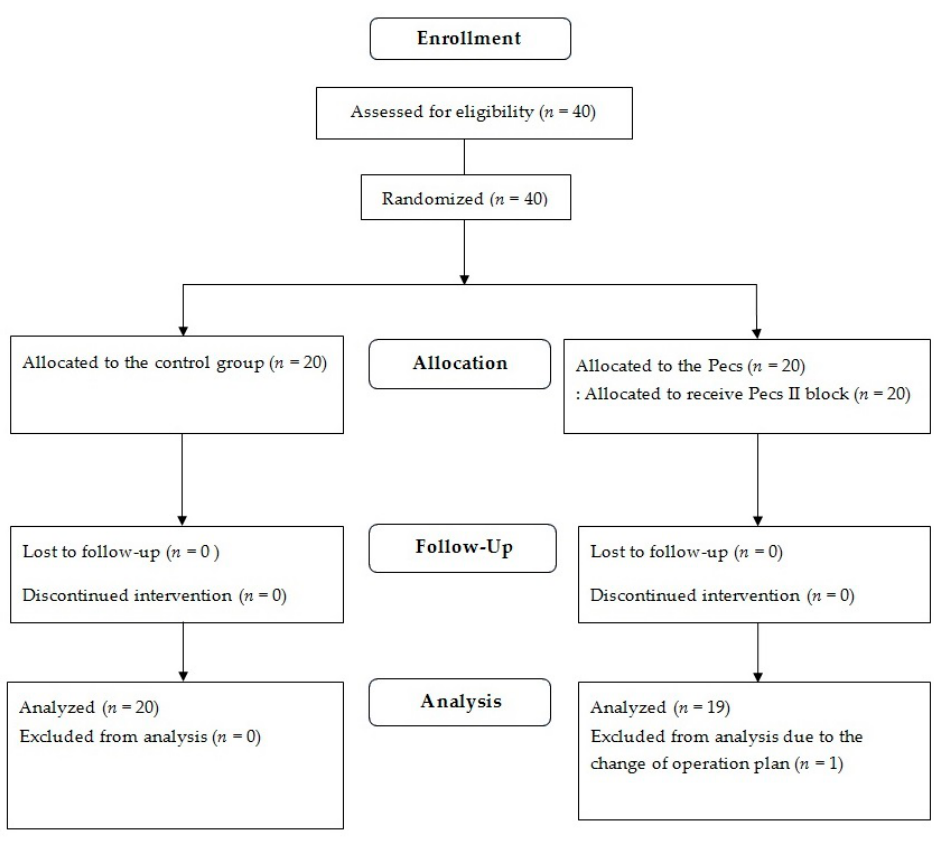
Figure 1. Flow diagram of patient allocation.